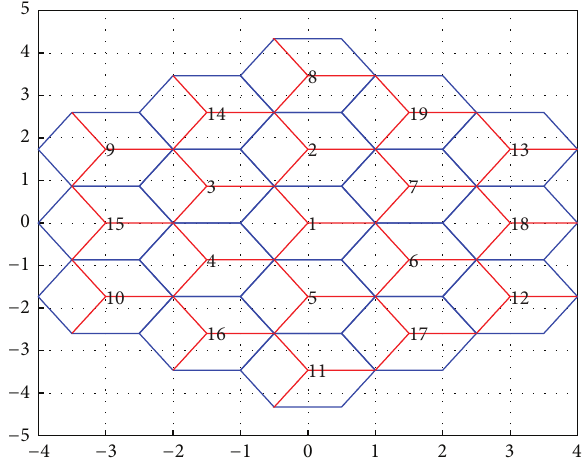
Figure 1: Cellular configuration (axes in